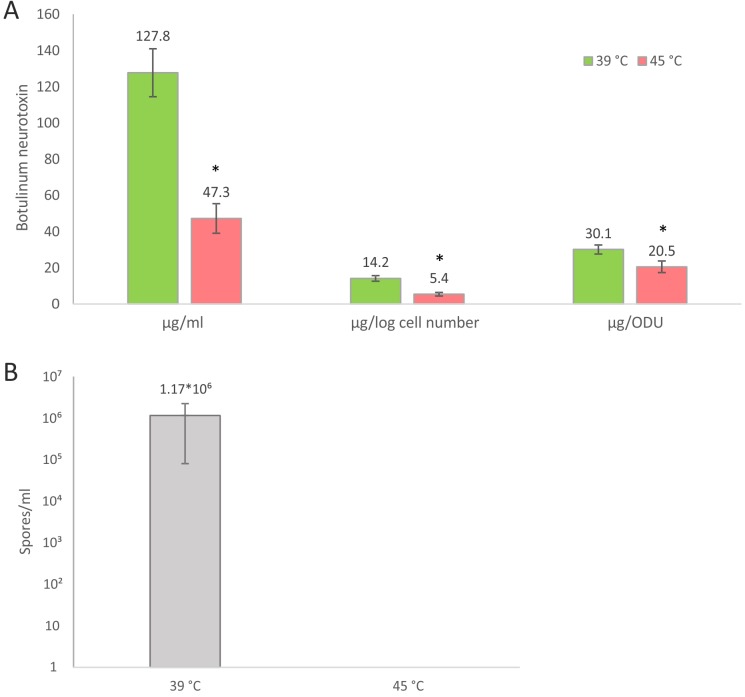
Batch culture growth of Clostridium botulinum at 45°C resulted in reduced toxin production (A) and abolished sporulation (B) compared to growth at 39°C. A. Concentrations of botulinum neurotoxin A (BoNT/A) detected with ELISA after 18 h of growth at 39°C (green bars) and 45°C (red bars); B. Spore count after 96 h of growth at 39 and 45°C. Error bars: standard deviation of five biological replicates, *: statistically significant (p < 0.05) difference between 45 and 39°C.